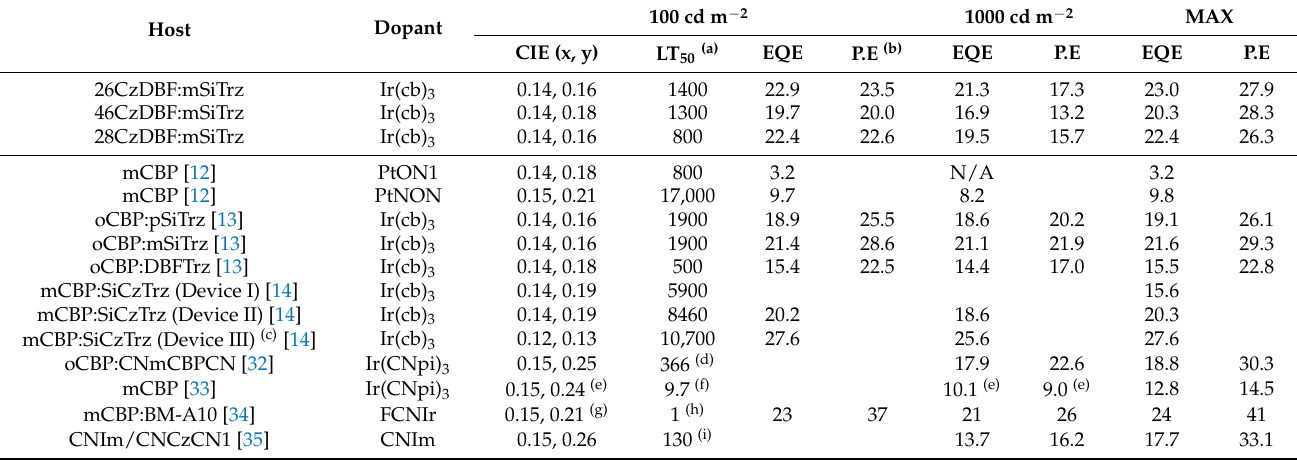
Figure 6. ( a ) Device lifetime data of the 26CzDBF:mSiTrz, 46CzDBF:mSiTrz, and 28CzDBF:mSiTrz deep blue PhOLEDs at an initial luminance of 100 cd m − 2 . ( b ) Voltage rise of HODs in the stability test at a current density of 2.5 mA cm − 2 . Table 2. Summarized device performances of deep blue PhOLEDs developed in this work compared with those of other devices in the